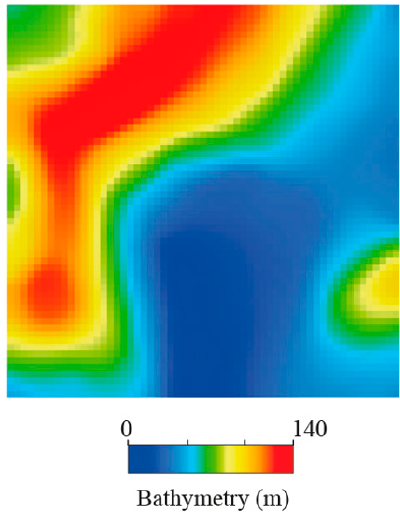
Figure 11. Bathymetry map for the interval 3 (181.7 to 181.5 Ma). Geosciences 2018 , 8 , x FOR PEER REVIEW